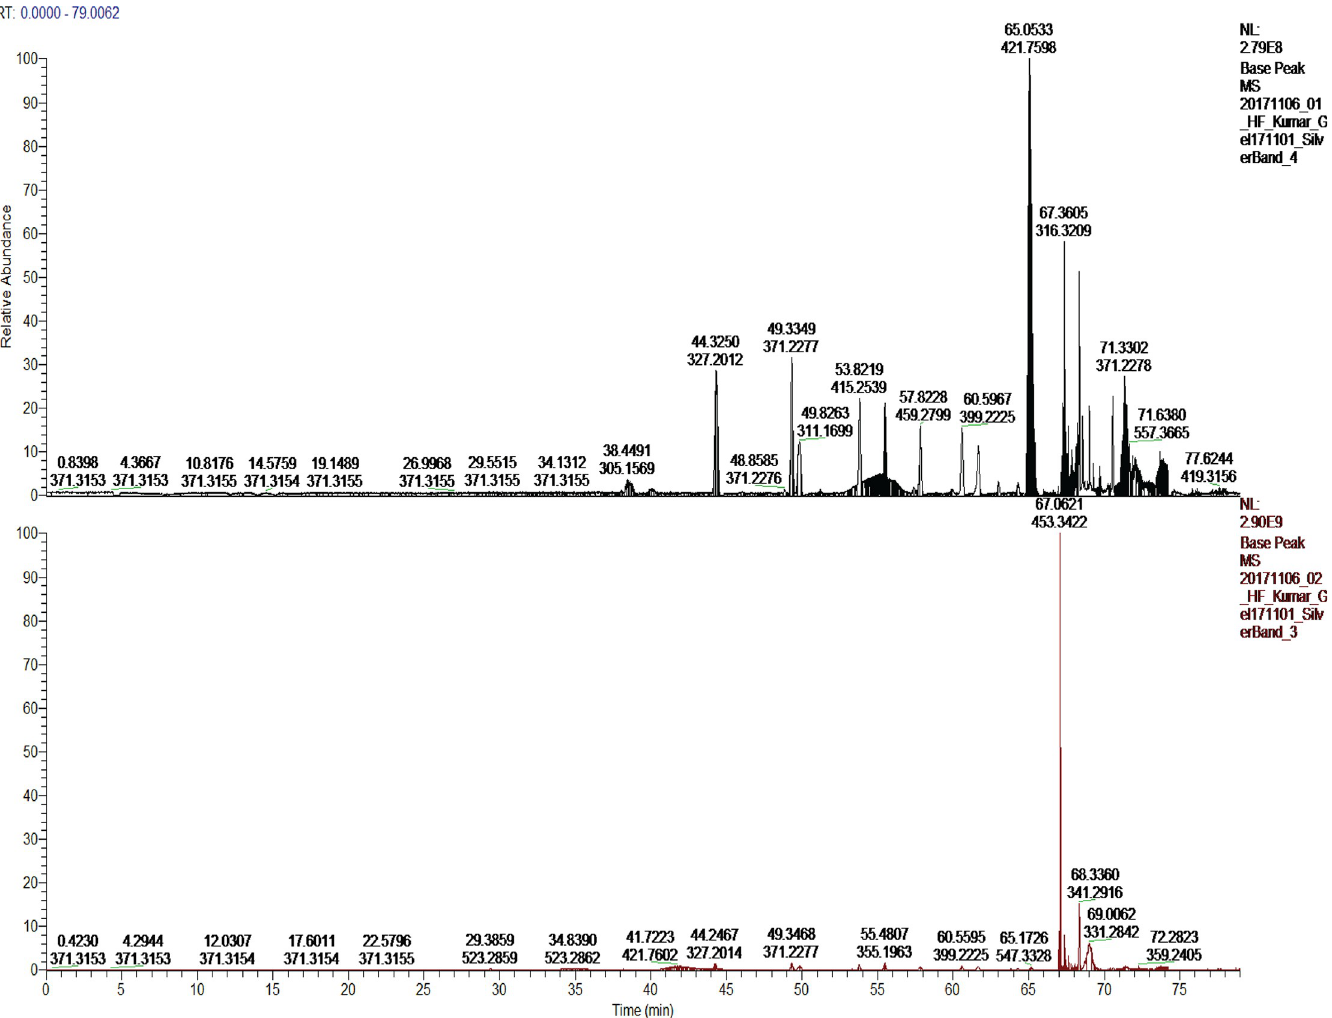
Fig 4. The arachidonic acid induced complex formation was detected with mass-spectrometry. Samples for MS were obtained from a native gel similar to those presented in Fig 1 in the S1 File. Bands were cut from the gel and treated for mass-spectrometric analysis as described in the experimental section. In A) all three proteins, FLAP, 5LO and MSP1E3D1 are present whereas in B) none of the three proteins are